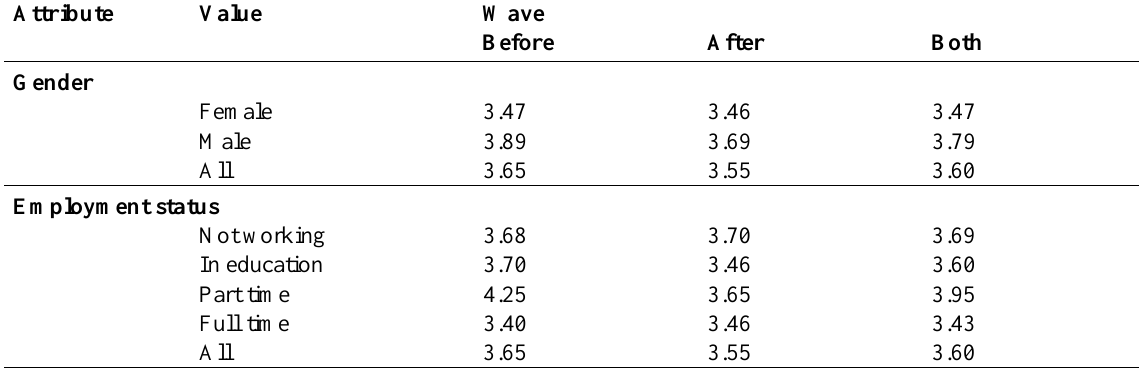
Table 3. Average number of trips by socio-demographic variables [trips/day] Attribute